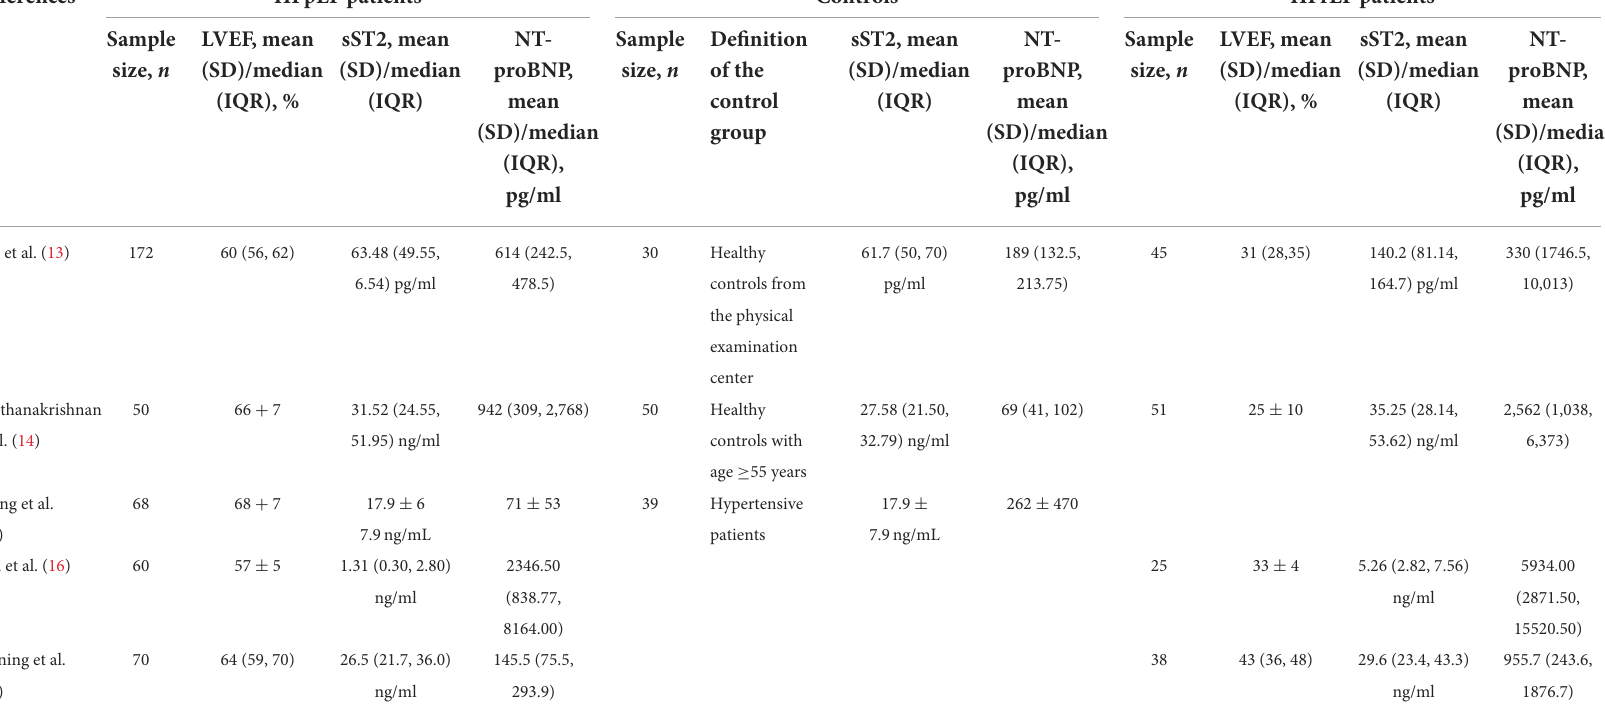
TABLE 2 Baseline characteristics of the 5 studies for diagnostic